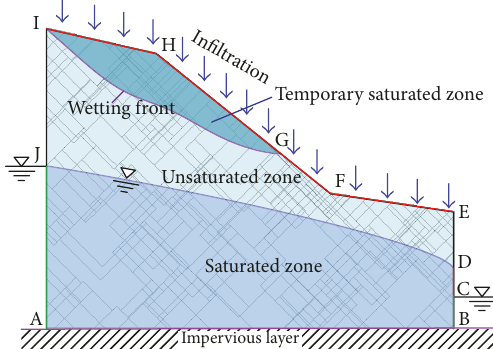
Figure1:Variably saturated flowmovement